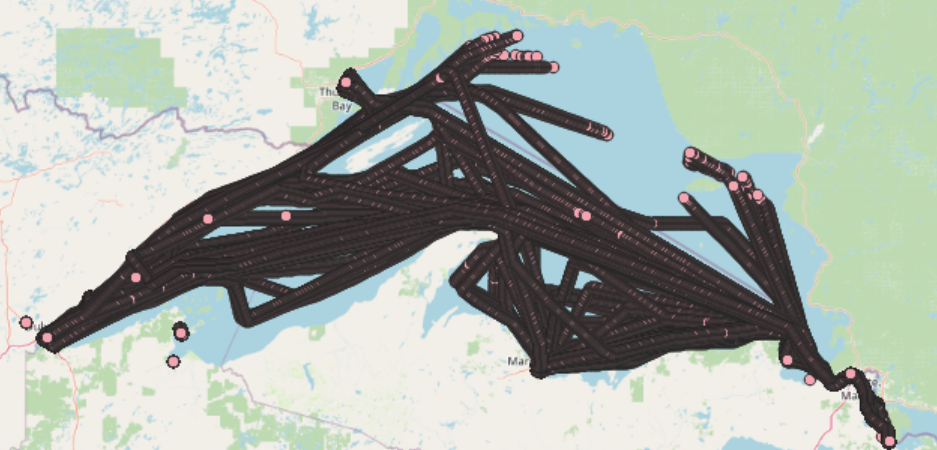
Figure 1. Routes in the selected area with different historical ways. The actual vessel location is at the center.